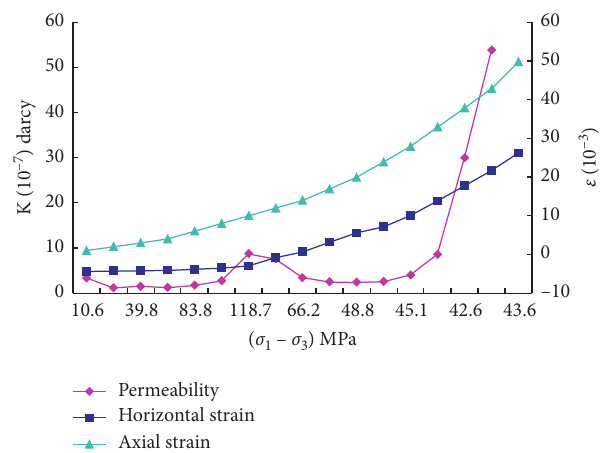
Figure 6: Permeability-horizontal strain-axial strain curves of W1-1.